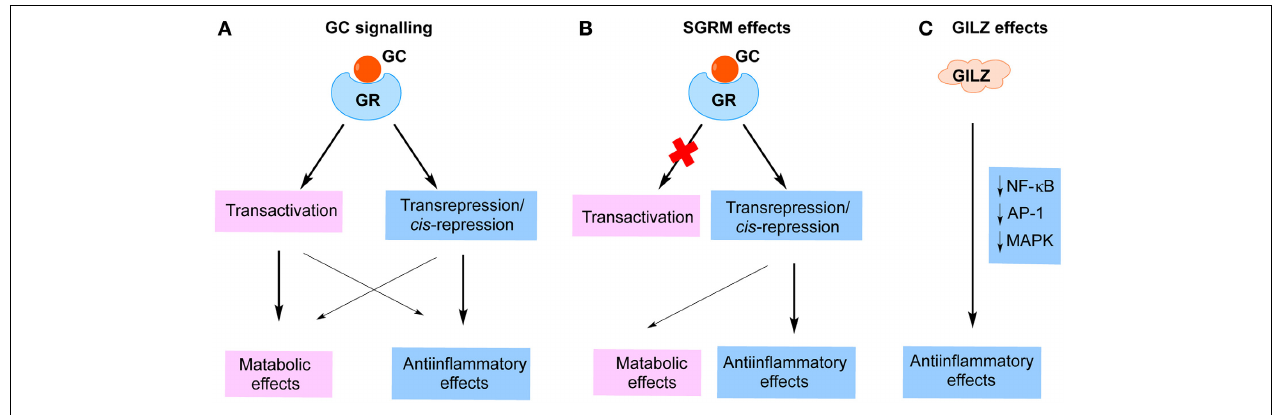
FIGURE 1 | Strategies to improve glucocorticoid therapy. (A) Cellular effects of glucocorticoids (GC). GCs bind to glucocorticoid receptor (GR) and activate intracellular signaling pathways. Previously, it was believed that transactivation predominantly accounts for the adverse metabolic effects, whereas transrepression/cis-repression mainly mediates anti-inflammatory